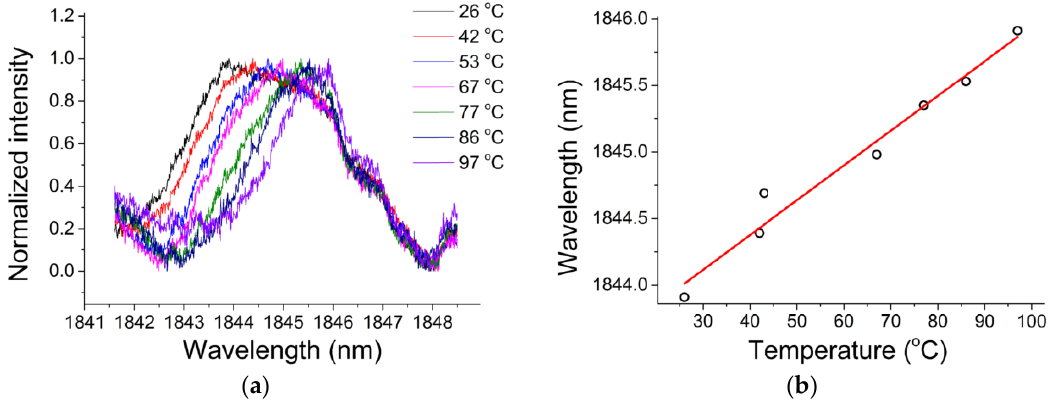
Figure 16. ( a ) Resonance spectra at different temperatures; ( b ) relationship between the wavelength shift and temperature. Reprinted/Adapted with permission from [71].